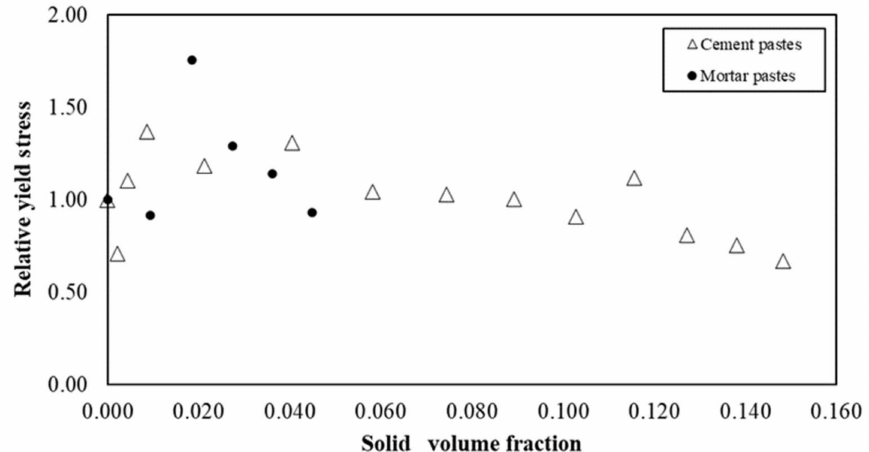
Figure 12. Relative yield stress for cement and mortar pastes with s/s